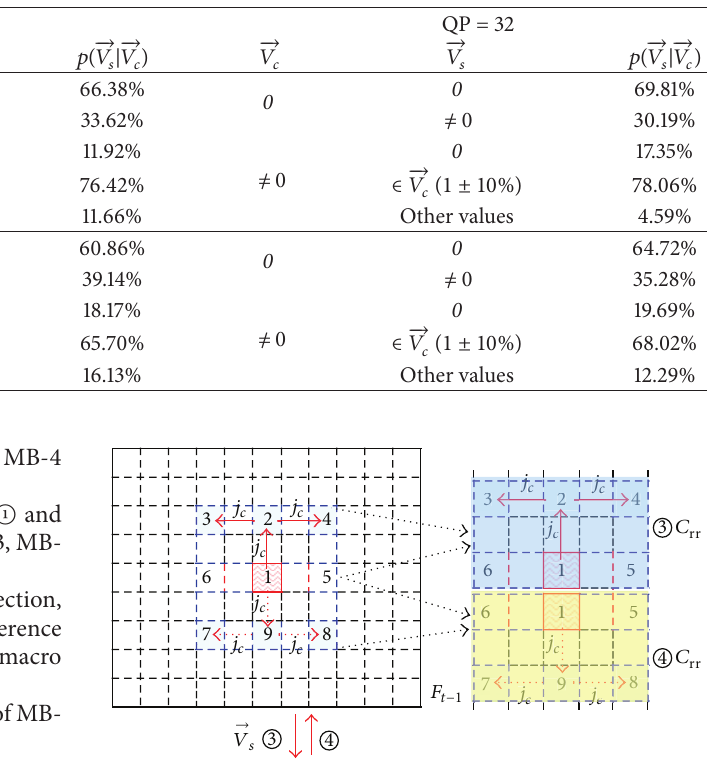
with vertical motion. rr